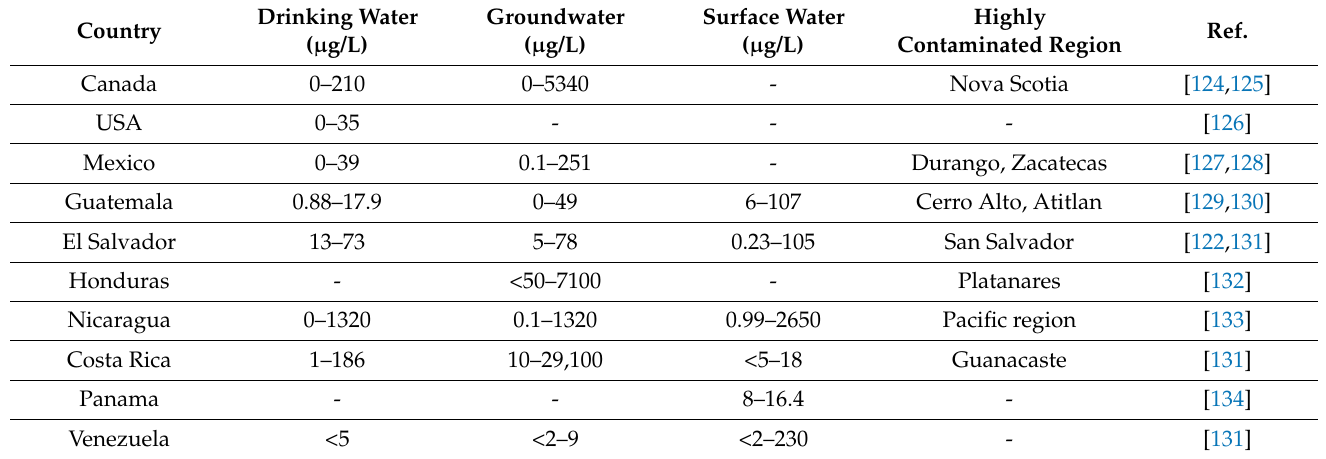
Table 5. American regions and concentration of arsenic in water (selected data from recent